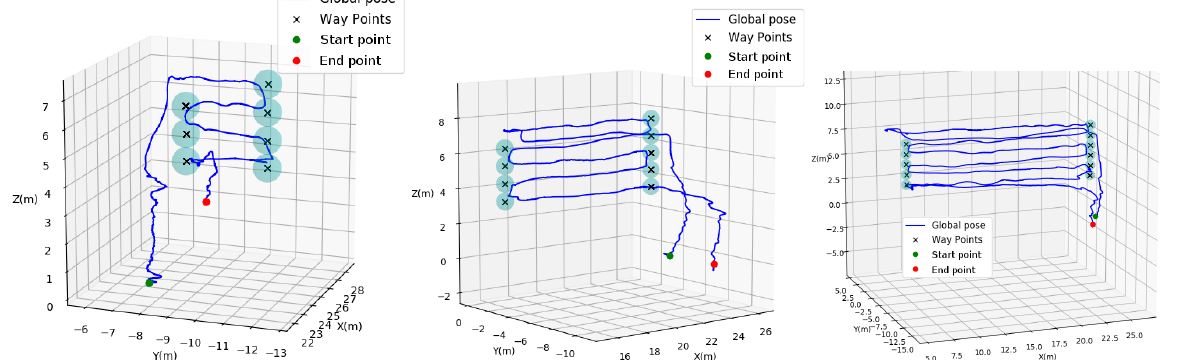
Figure 21. Estimated paths for different flights performed on-board a bulk carrier. In the plots, × in the center of a blue sphere denotes a